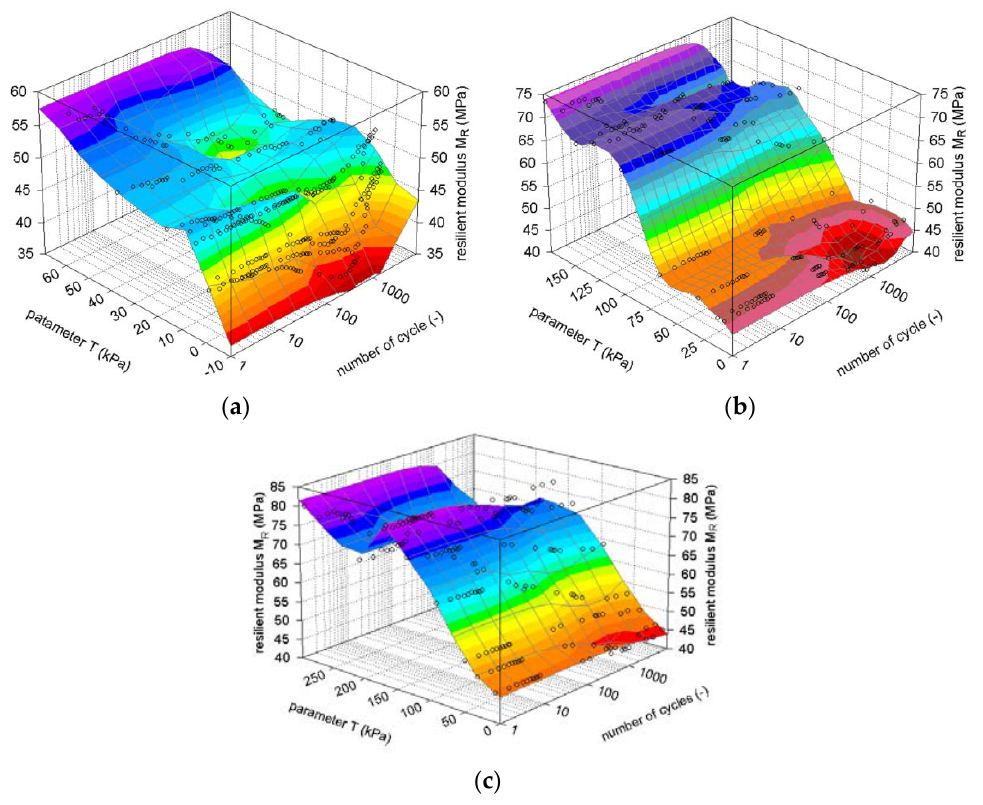
Figure 10. Resilient modulus versus the number of cycles and analytical model T parameter for test results in 3D plots for isotropically ‐ consolidated sandy clay ( a ) σ ’ 3 = 45 kPa; ( b ) σ ’ 3 = 90 kPa; and ( c ) σ ’ 3 = 135 kPa.